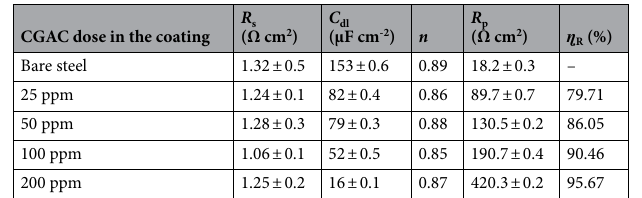
Table 3. Electrochemical impedance parameters and the corresponding protection efficiency ( ɳ R %) for the bare and different CGAC coated steel samples in 3.5 wt.% NaCl solution at 25